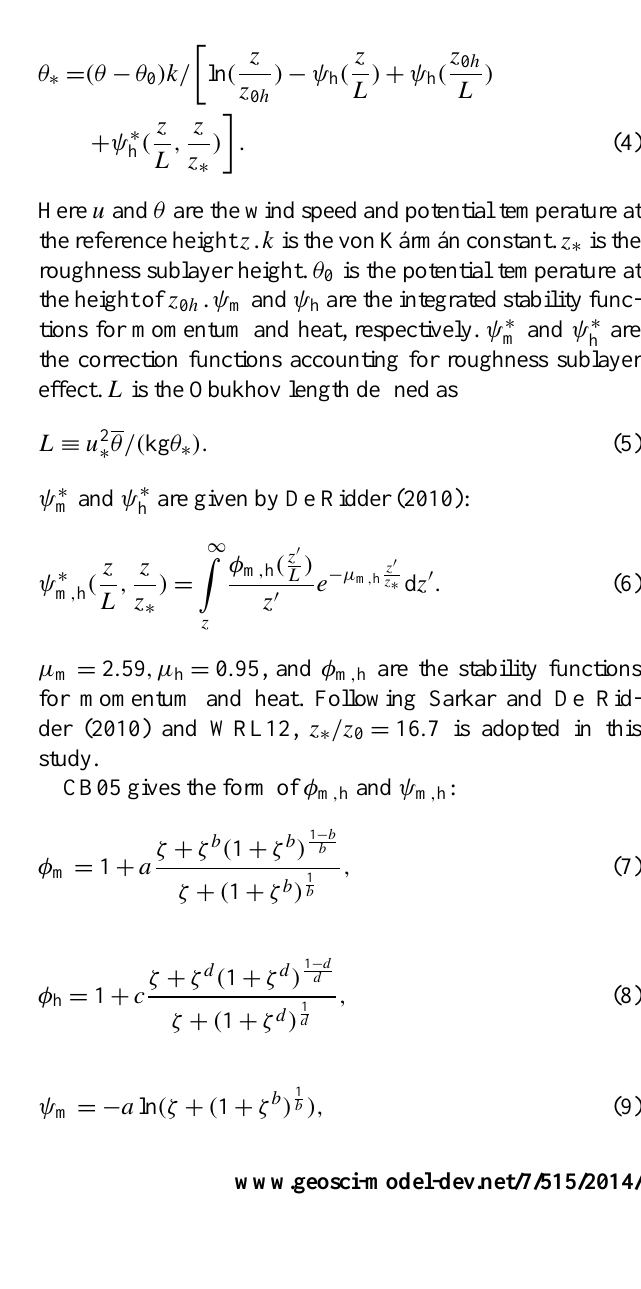
Fig. 9. Similar to Fig. 8 but for C M . Figure 9.Similar toFigure 8 but for C M . 2